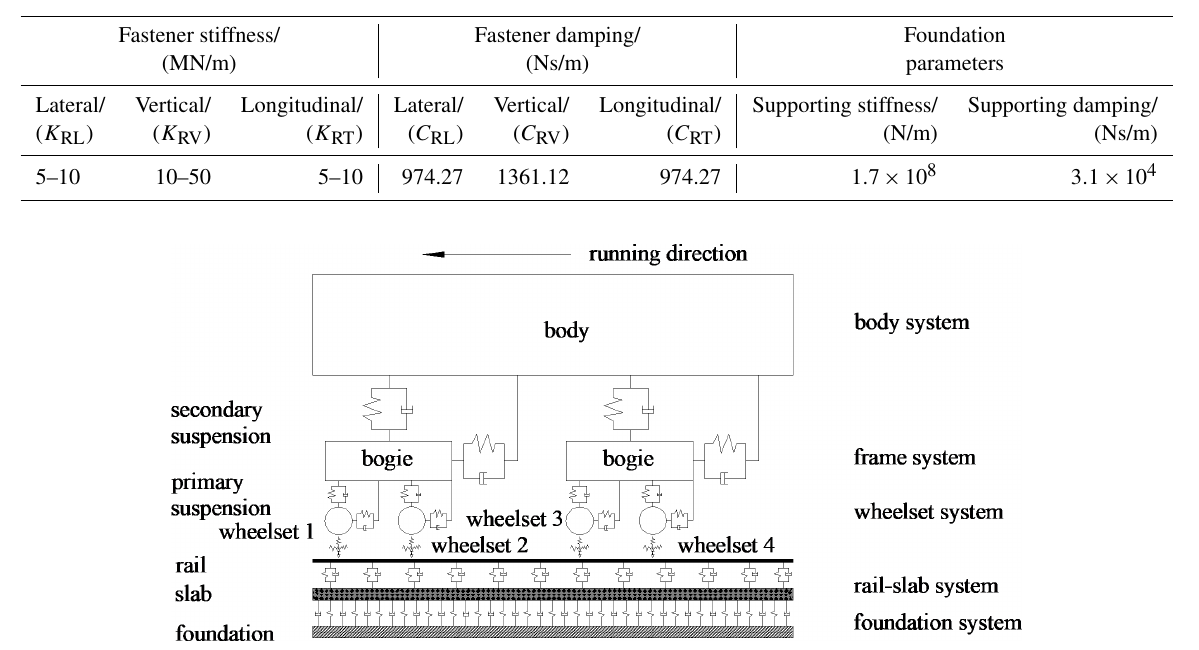
Table 1. Fastener and foundation parameters.